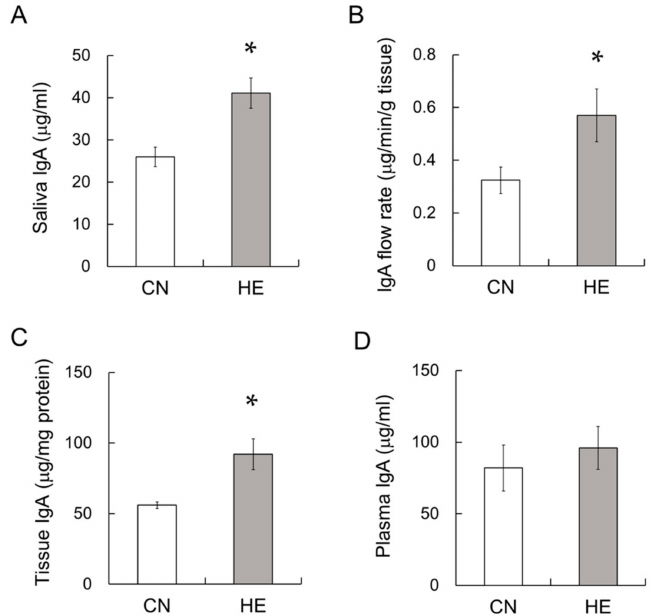
Figure 2. Salivary immunoglobulin A (IgA), IgA flow rate, IgA in the submandibular glands (SMGs) and plasma IgA levels in control (CN) and heat-exposed (HE) rats. ( A ) IgA concentration in saliva. ( B ) IgA flow rate. ( C ) IgA concentration of the SMGs and ( D ) plasma. Values are presented as the mean ± SEM ( n = 8 in each group). * p < 0.05, significant di ff erence between the CN and HE